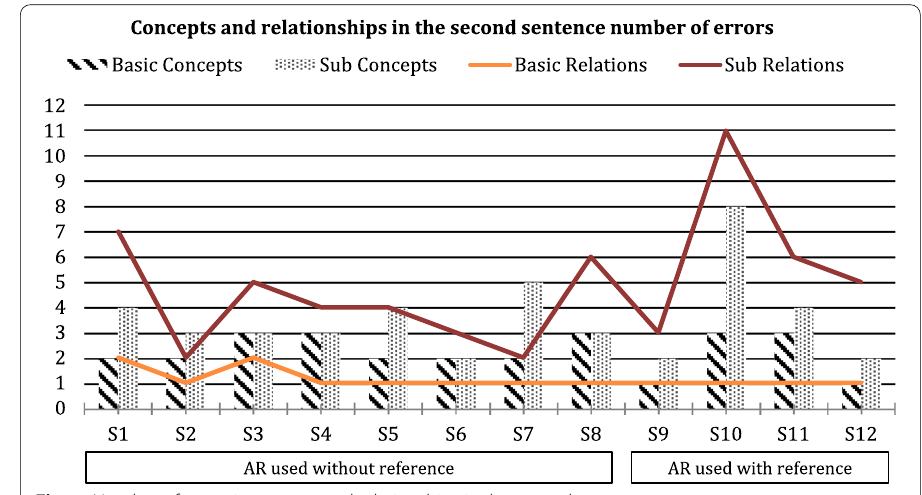
Fig. 7 Number of errors in concept and relationships in the second